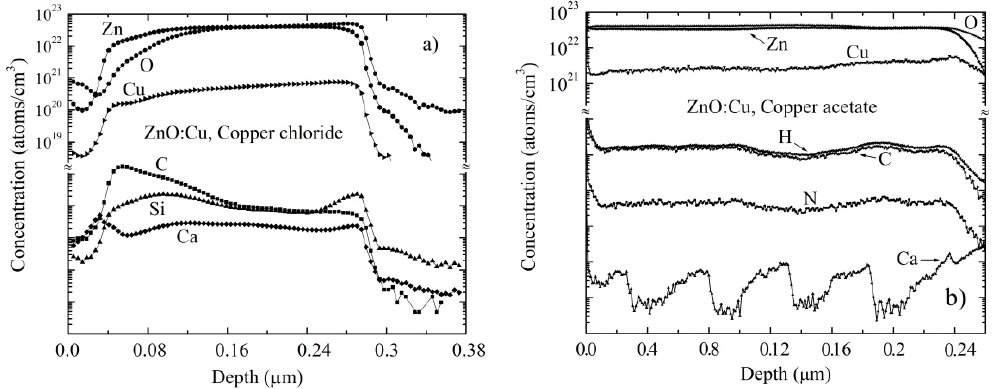
Figure 3. Secondary ion mass spectrometry (SIMS) depth profiles for the six ‐ times dipped Cu ‐ doped ZnO film deposited with ( a ) copper chloride, ( b ) copper acetate.